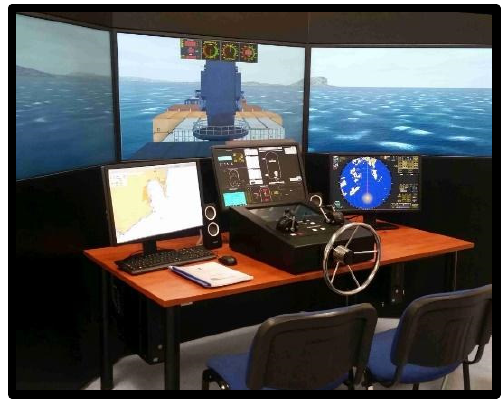
Figure 2. K-Sim Polaris simulator instructor station.